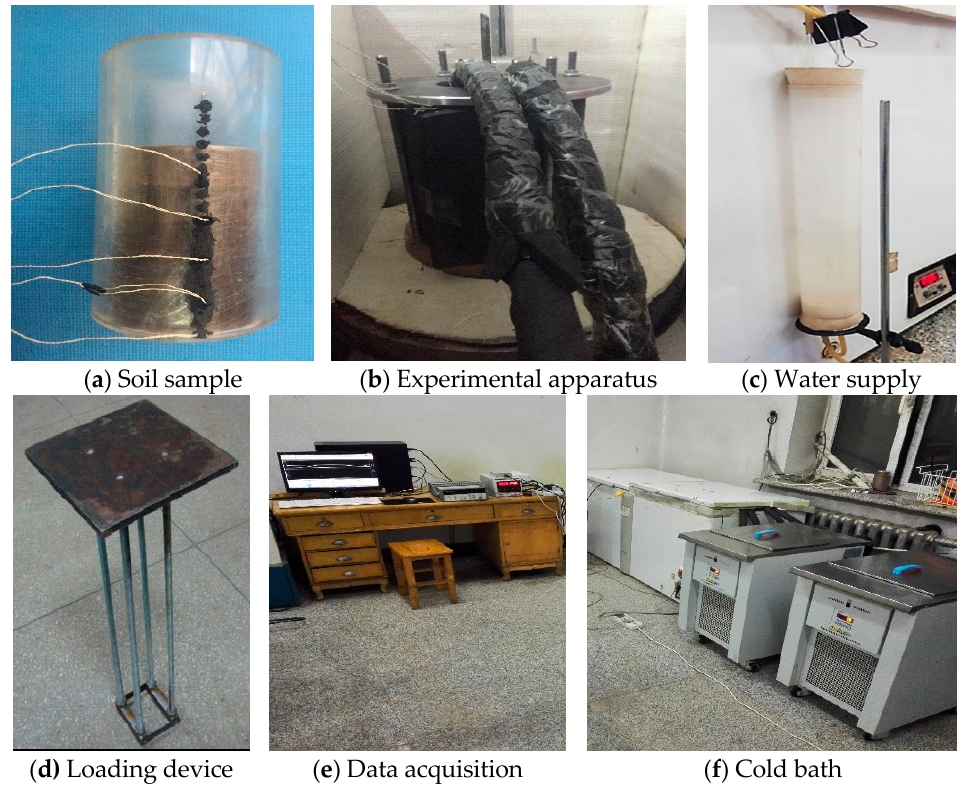
Figure 1. Experiment setup in one-dimensional freezing heave test: ( a ) soil sample, ( b ) experimental apparatus, ( c ) water supply, ( d ) loading device, ( e ) data acquisition, and ( f ) cold bath.